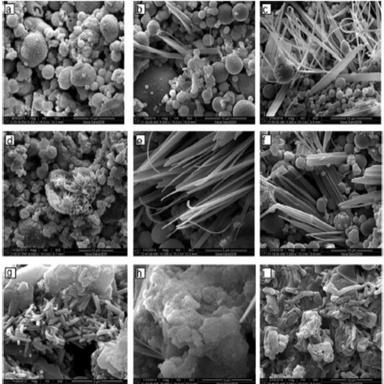
Fly ash based geopolymers SEM pictures (a) 6M27, (b) 6M45, (c) 6M60, (d) 8M27, (e) 8M45, (f) 8M60, (g) 10M27, (h) 10M45, (i) 10M60